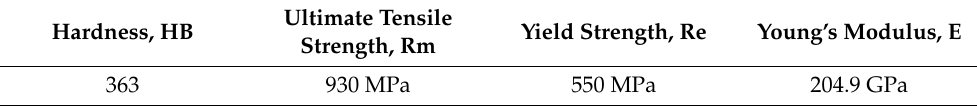
Table 2. Mechanical properties of Inconel 718 [19].